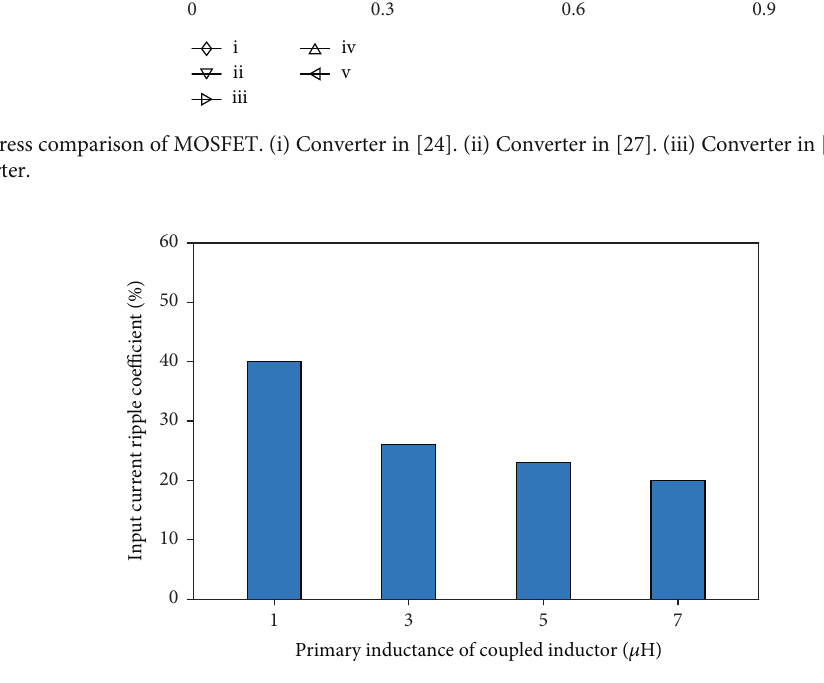
Figure 9: The relationship between the original inductor and current